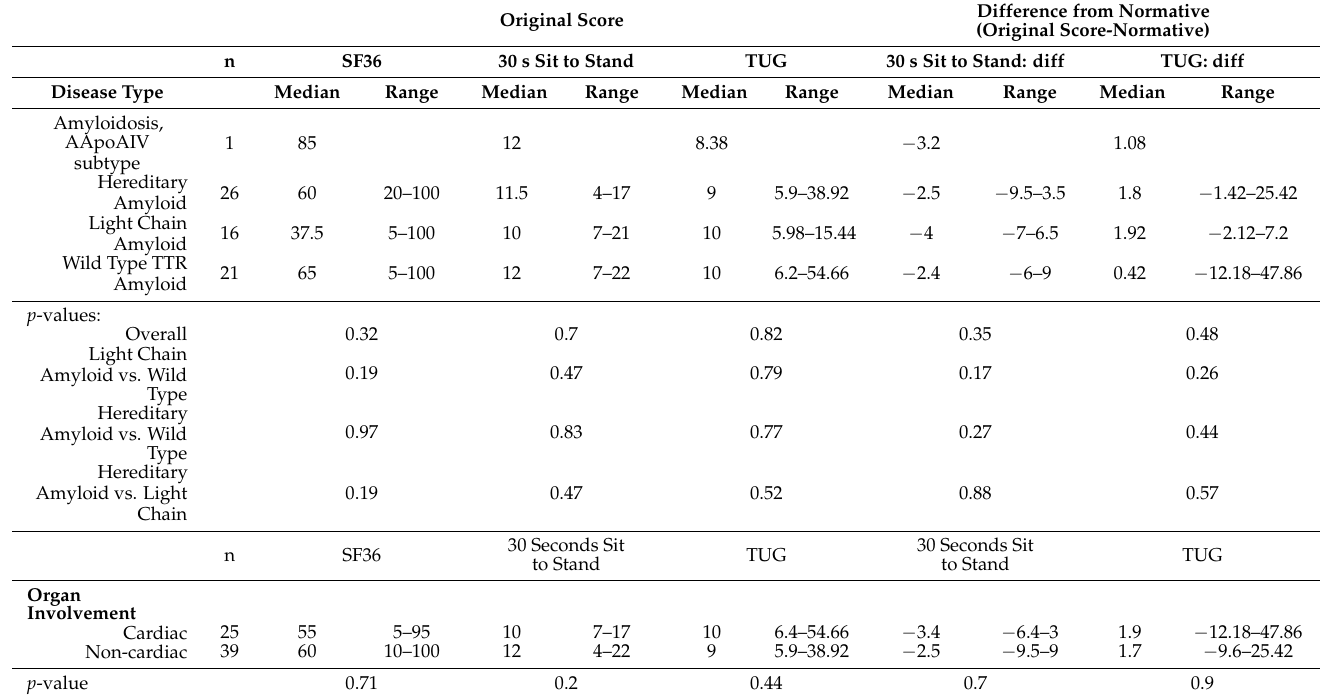
Table 2. Comparison of performance scores among disease type and organ involvement. Original